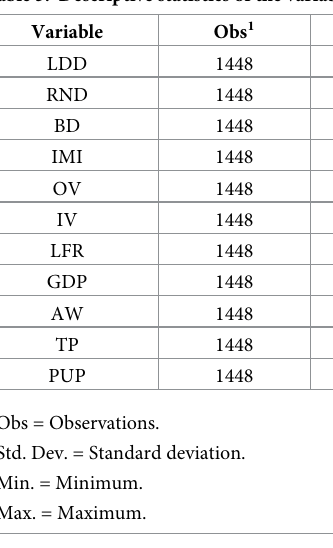
Table 3. Descriptive statistics of the